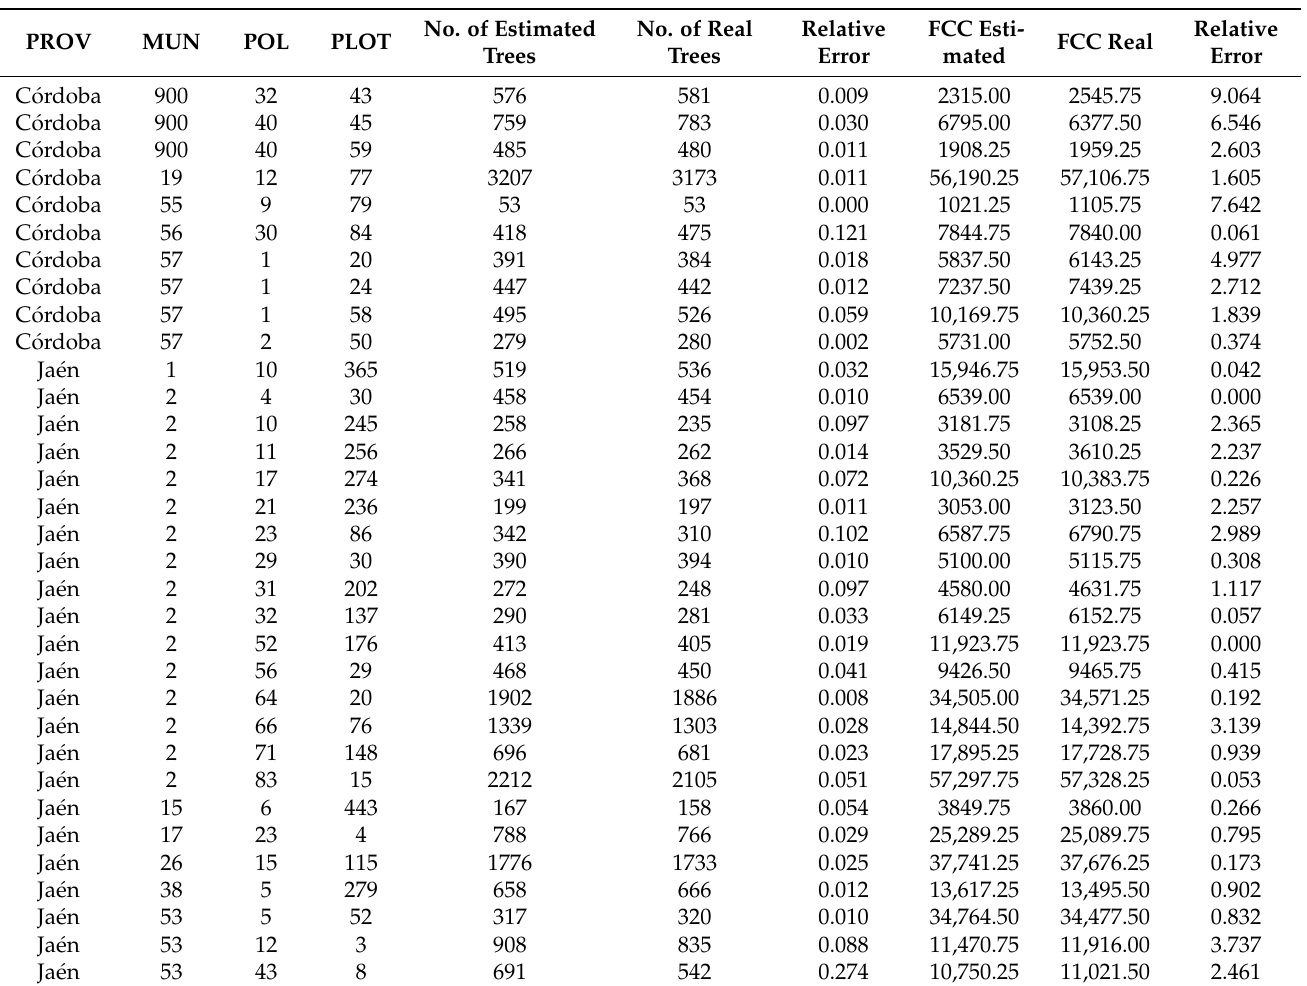
Table 2. Results of the validation of the tool for olive groves in 33 plots.